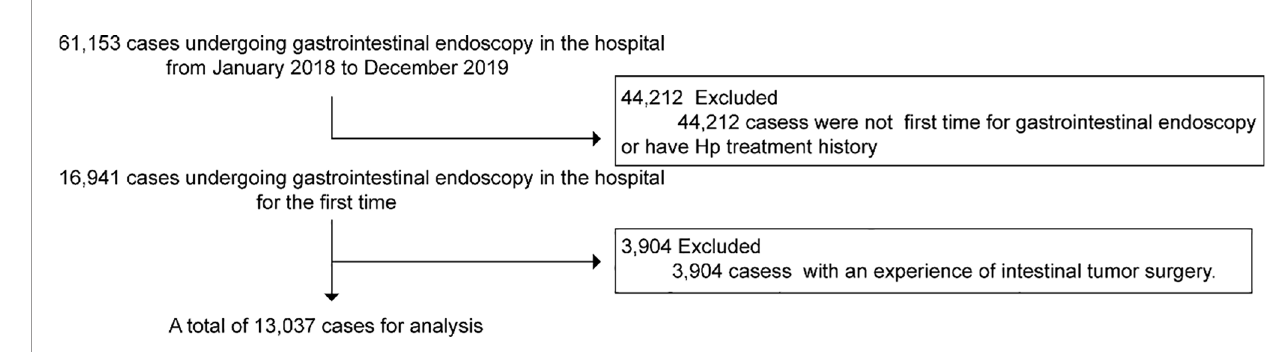
FIGURE 1 | Flowchart of cases selection.